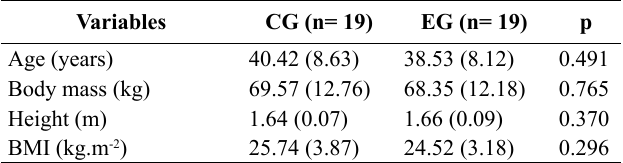
Table 1. Antrophometric data (mean and standard deviation).